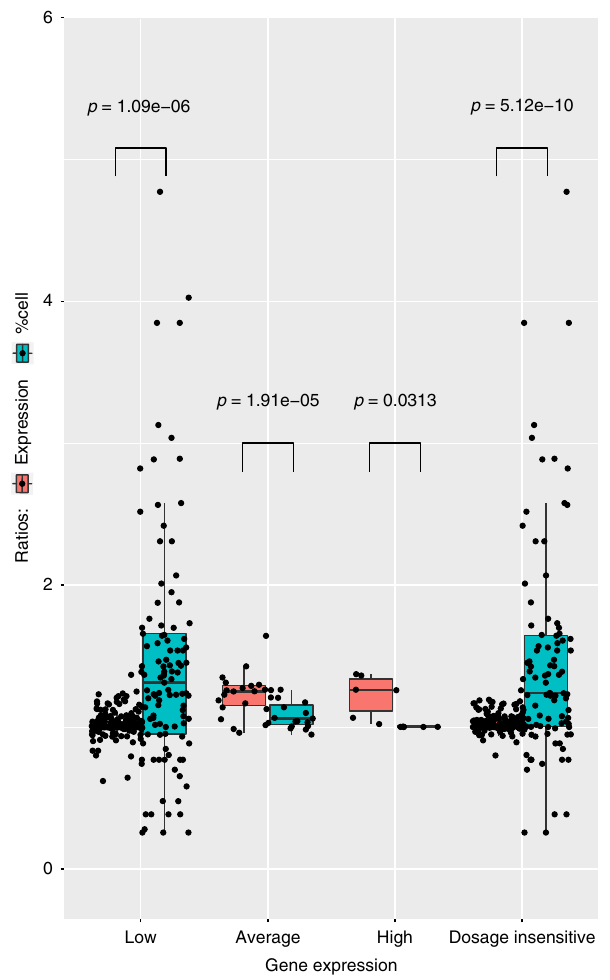
Fig. 8 Components of gene dosage imbalance in trisomy 21 using 8740 single fi broblasts. Left: Gene dosage imbalance components in low (<3 FPKM), medium (3 FPKM< and <15 FPKM) and high (>15 FPKM) expressed genes. For low expressed genes, dosage imbalance is mainly driven by the increased fraction of trisomic cells expressing these genes compared to diploid. For medium and highly expressed genes, the dosage imbalance is mainly driven by the trisomic/diploid FC expression per cell while no signi fi cant difference in the fraction of cells can be detected. Right: statistically signi fi cant differences of trisomic/diploid ratio of fraction of expressing cells in non-dosage sensitive genes in single cells (0.8 < FC < 1.2). Boxplot: horizontal lines indicate medians; upper and lower boxes indicate fi rst (25th percentile) and third quartiles (75th